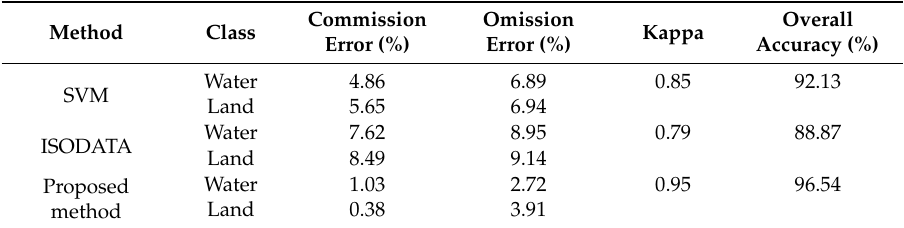
Table 2. Summary of classification accuracy of three different methods.